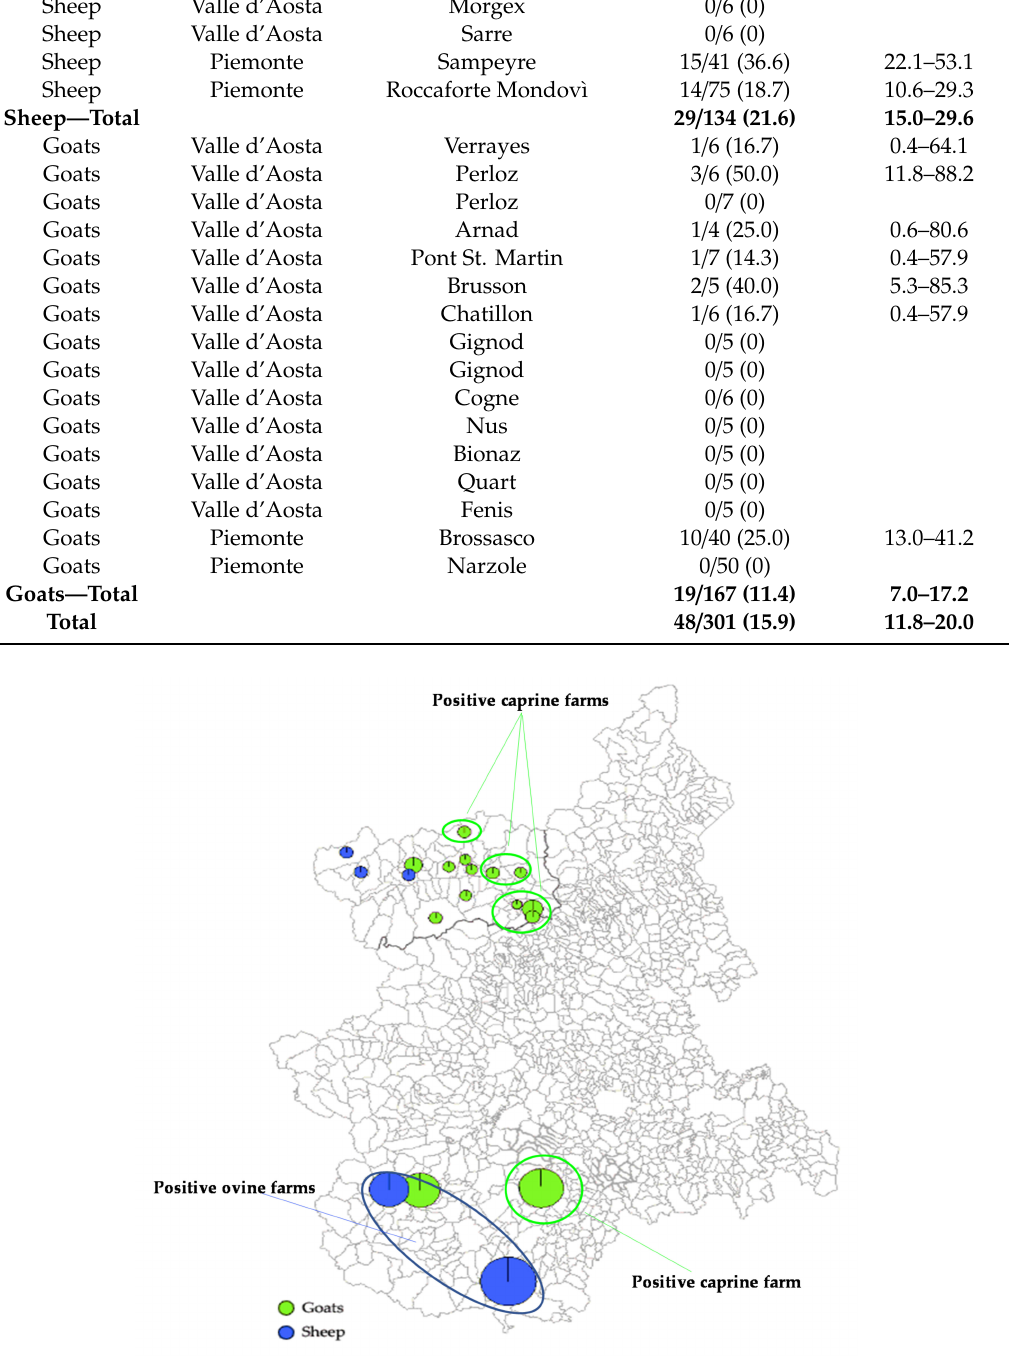
Figure 2. Geographical distribution (Piemonte and Valle d’Aosta) of sheep and goat farms positive for HEV